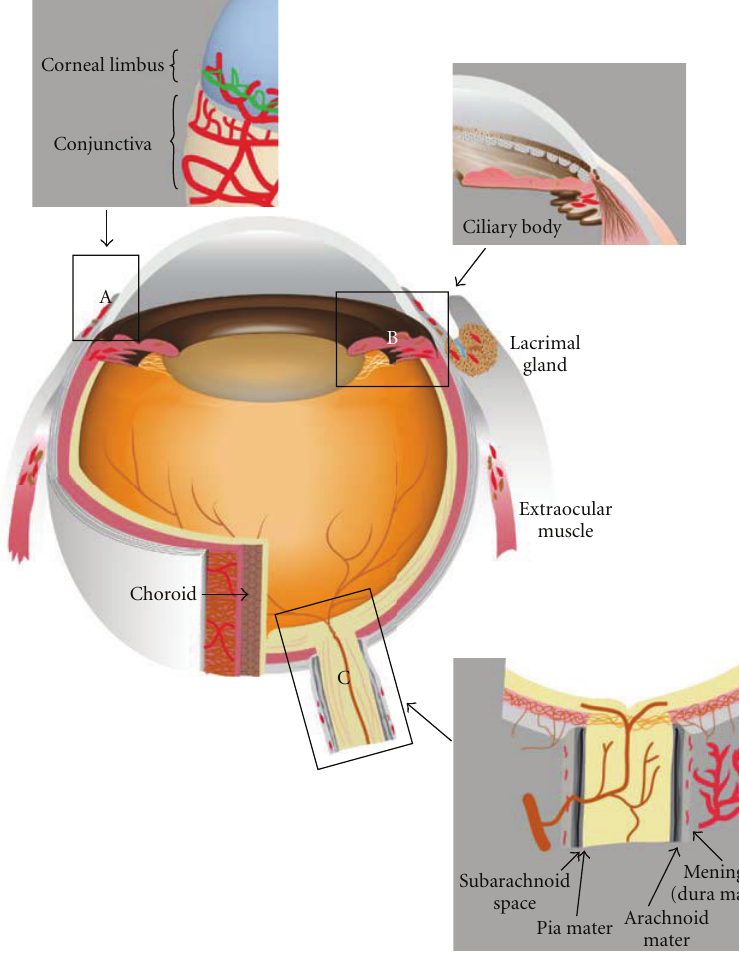
Figure 1: Distribution of lymphatics in the eye. Immunological staining with lymphatic specific markers as well as histological examinations has revealed the distribution of lymphatic vessels in the eye. Conjunctiva is well known to possess lymphatics. Cornea limbus, ciliary body, lacrimal gland, orbital meninges and extraocular muscle also contain lymphatic vessels, and choroid might have lymphatic-like system. Cornea, retina, and optic nerve do not show lymphatics. Intraocular lymphatic can be observed only in the ciliary body. (A), (B), and (C) show the details of corneal limbal area, angulus iridocornealis, and optic nerve, respectively. Red indicates lymphatic vessels.